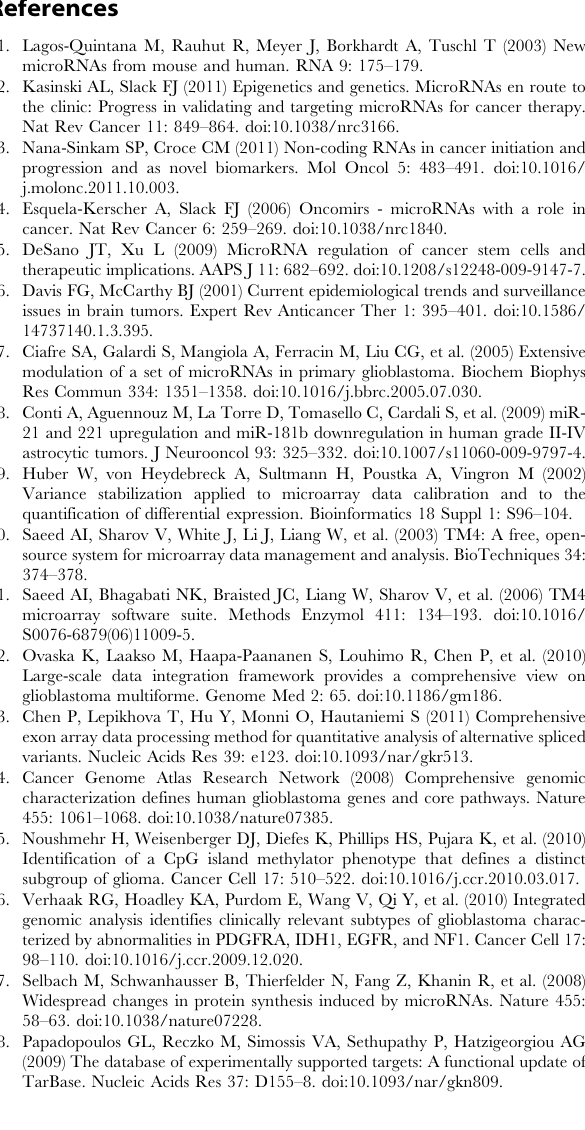
performed with three to four biological replicates. Arrows denote miRNAs that were selected for further validation. Figure S2 Cell cycle analysis after miRNA precursor overexpression using the Click-it Edu Alexa 647 nm fluor HCS assay kit (Invitrogen Carlsbad, CA, USA) and Hoechst 33342 stain for the A172, LN405, and U87MG cells. Each assay was repeated three times with a 48 h time point after miRNA transfection. Values are mean + / 2 s.e.m.; statistically significant changes are shown with asterisks (*p- Figure S3 Kaplan-Meier analysis of the MET oncogene in the clinical GBM samples (n =382 in total). Significant survival difference with p , 0.0368 was seen between the MET low expression group (group denoted with –1, blue line, n= 225) with better survival and the high expression group (denoted with 1, red